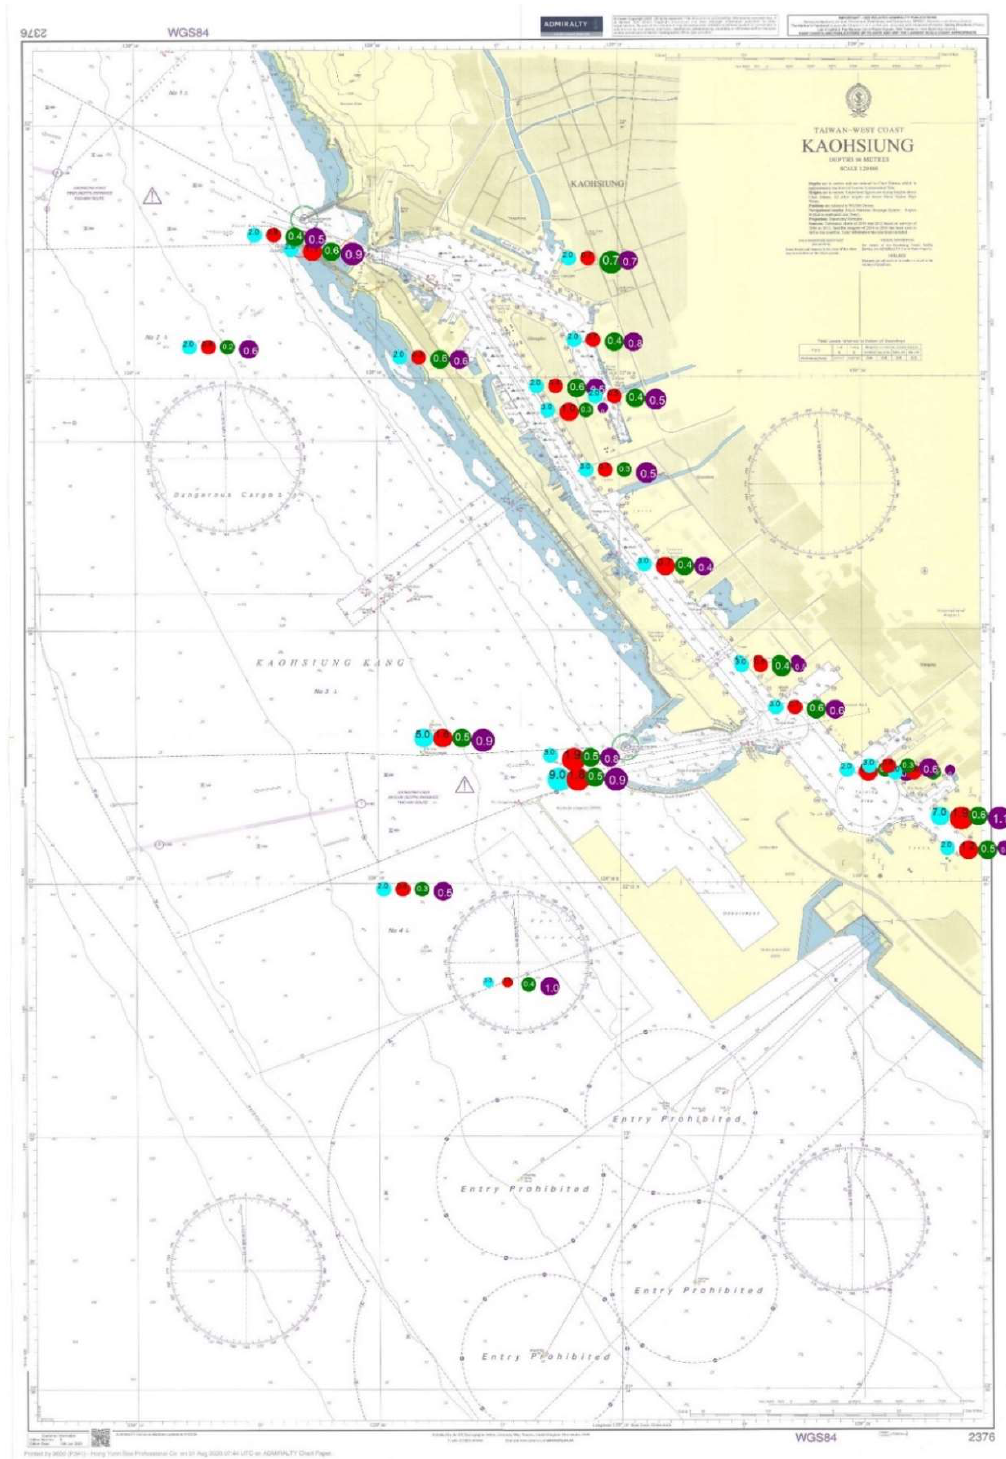
Figure 8. The locations of marine accidents and the levels of wind, wave, tide, and current in the port of Kaohsiung. Note: a blue circle is wind speed and the number inside a blue circle is level of wind speed; a red circle is wave height and the number inside a red circle is level of wave height; a green circle is tide height and the number inside a green circle is level of tide height; a purple circle is current speed and the number inside a purple circle is level of current speed; a set of data (four circles including blue, red, green, and purple circles) means one marine accident, and the position of the blue circle is the location of that marine accident.